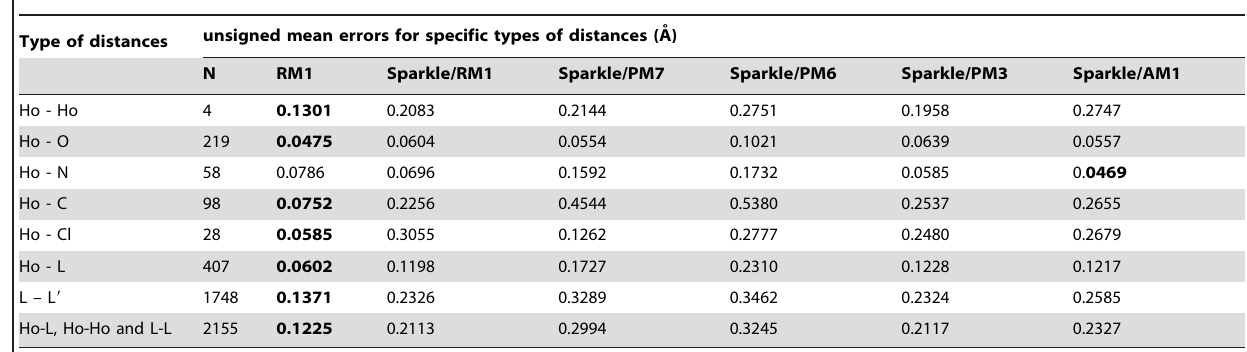
Table 8. RM1, Sparkle/RM1, Sparkle/PM7, Sparkle/PM6, Sparkle/PM3, and Sparkle/AM1 unsigned mean errors for specific types of distances for holmium(III) complexes.